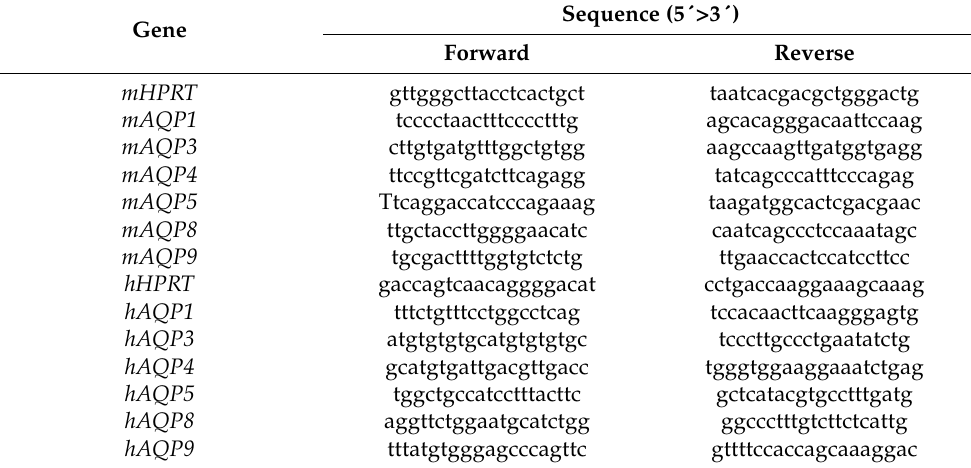
Table 3. Real-time PCR